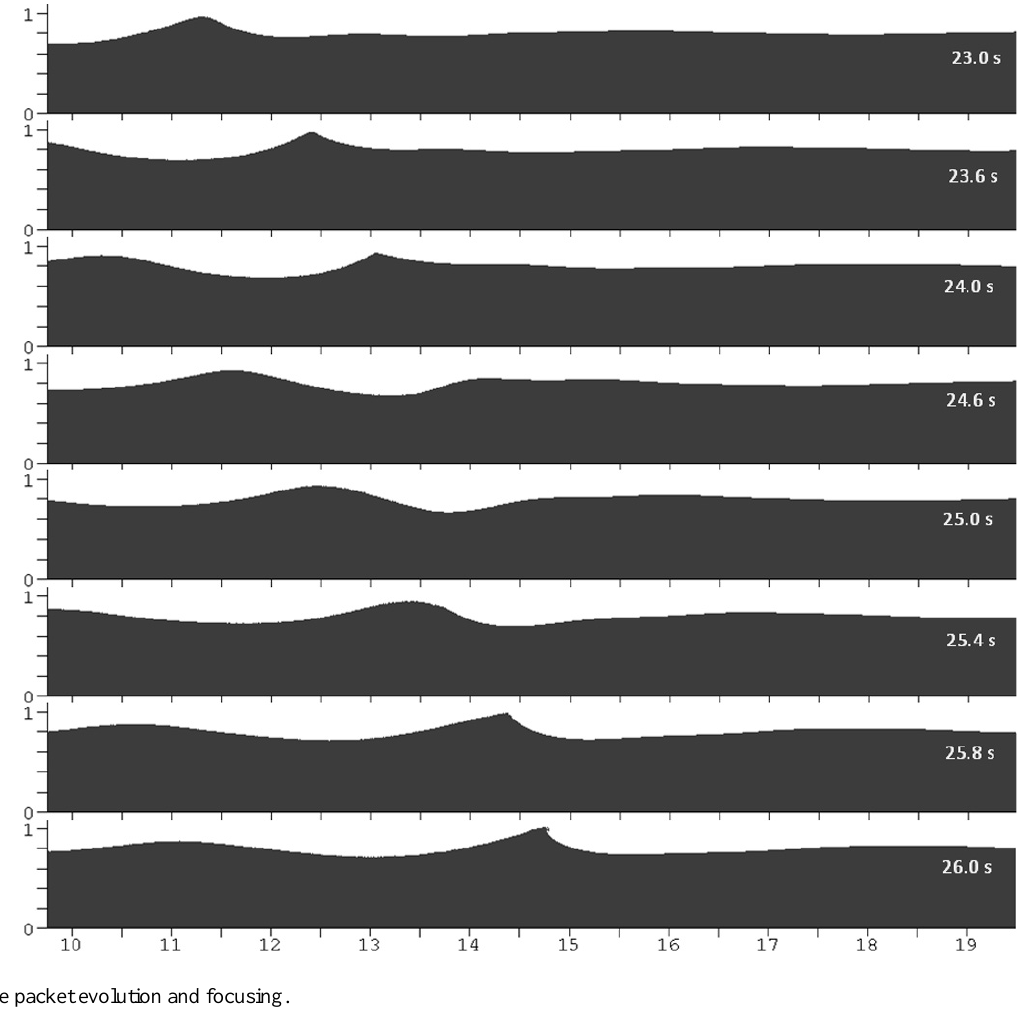
Fig. 6. Wave packet evolution and